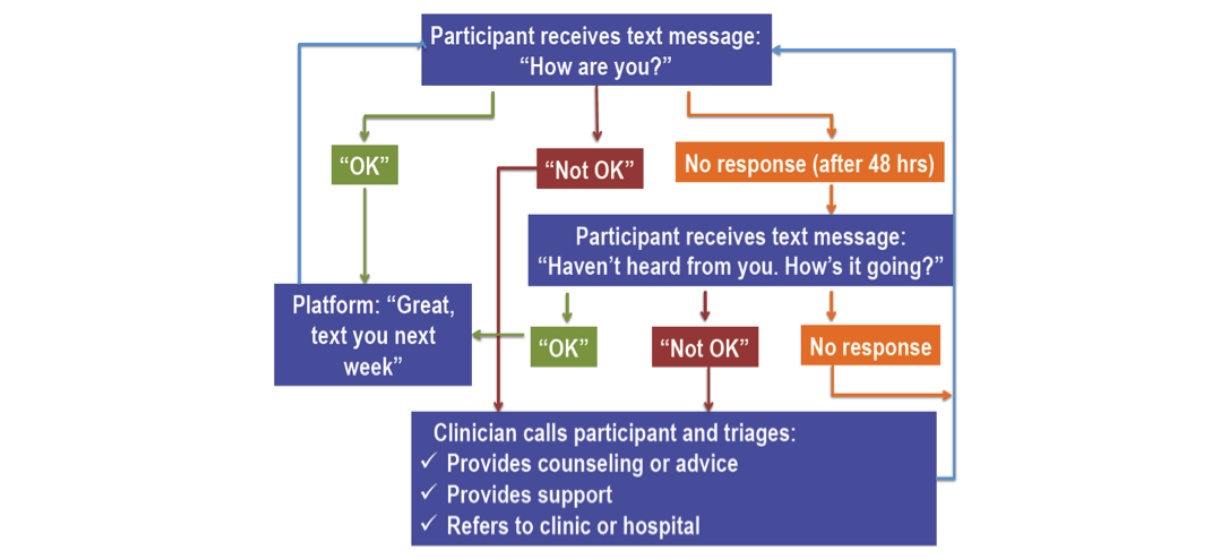
Figure 1. Weekly text-messaging